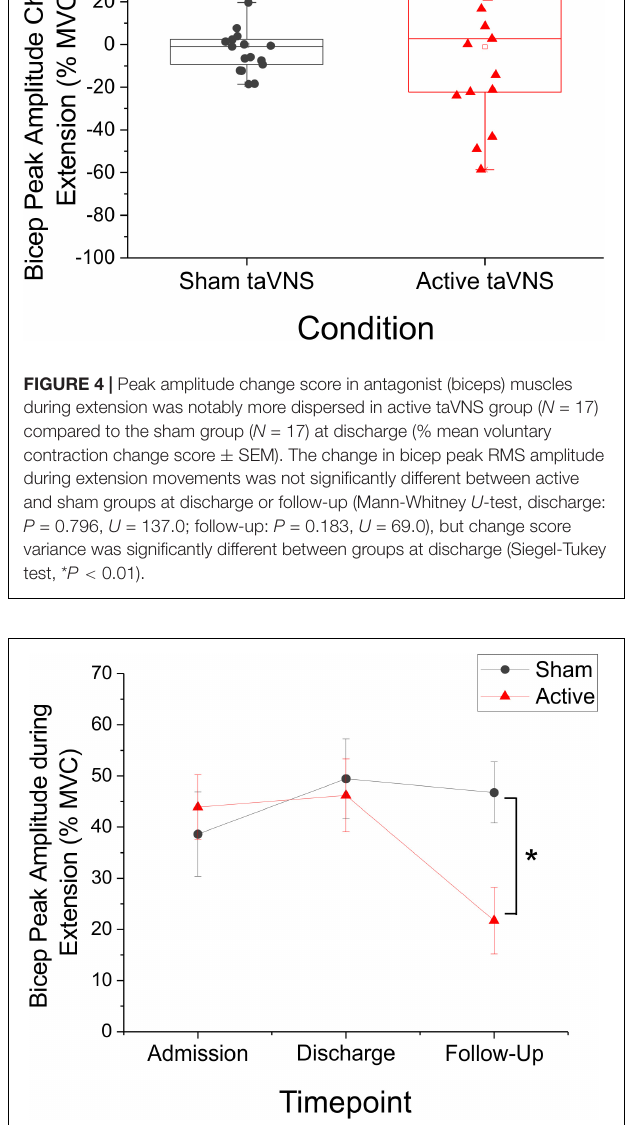
There were no significant changes in the biceps median frequency, the ratio of biceps to triceps, or in the triceps across all sEMG measures during